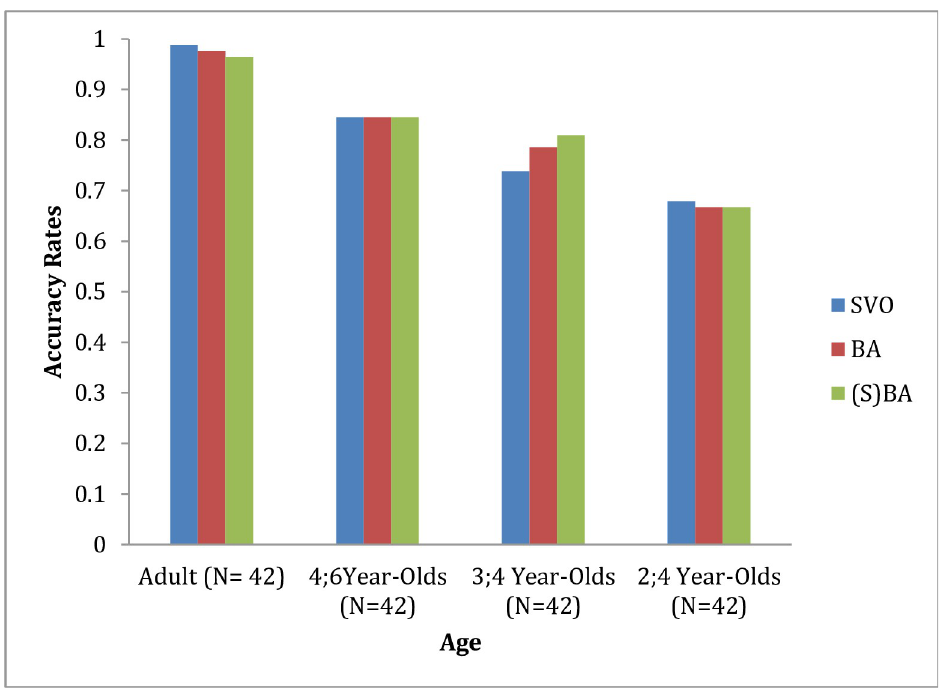
Fig 1. Mean proportion identifying the correct agent as a function of age and construction